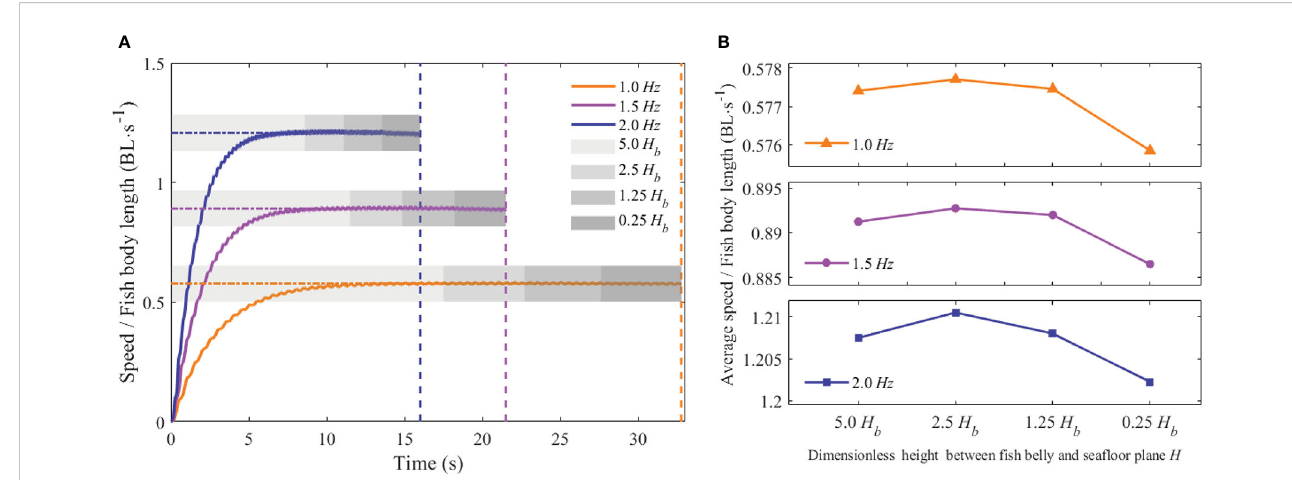
FIGURE 8 Forward speed of the swimmer at different values of f and H (A) Instantaneous forward speed (B) Average forward